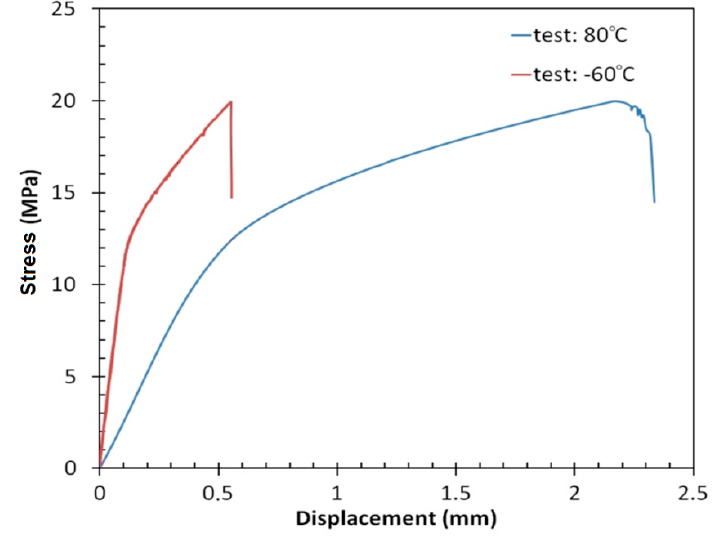
Figure 13. Stress–displacement curves after tensile/shear tests.